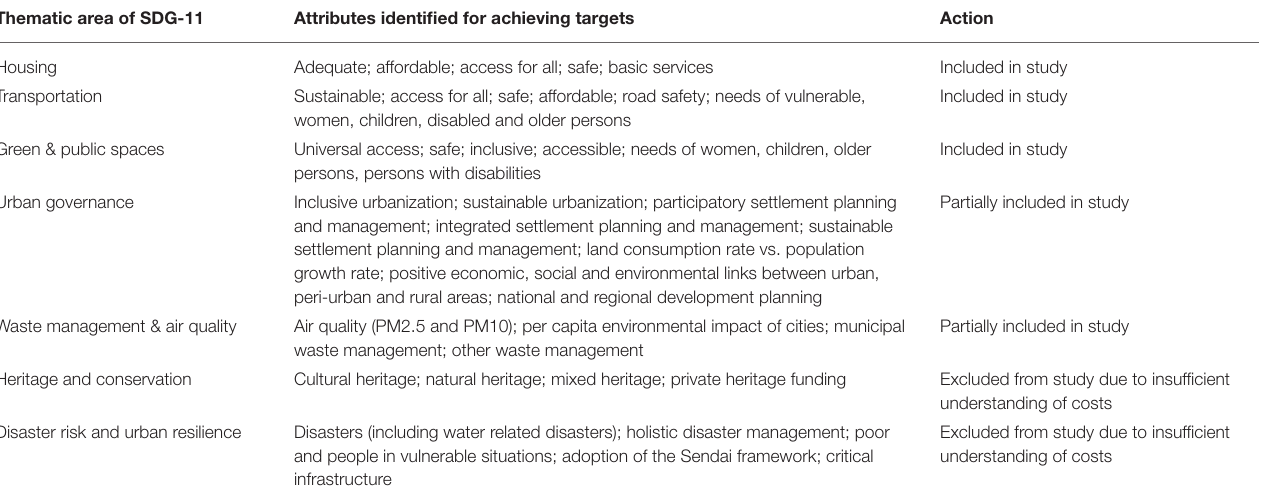
TABLE 1 | Breakdown of SDG-11 targets into attributes that need to be achieved by 2030 and inclusion status in